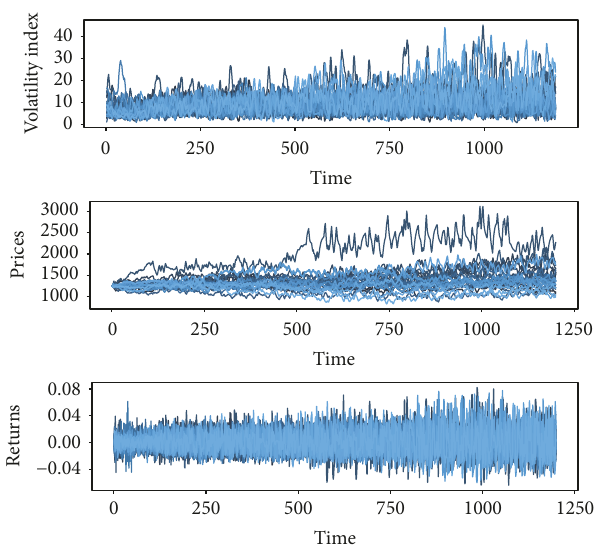
Figure 6: The market prices, returns, and volatility index under decentralized network.